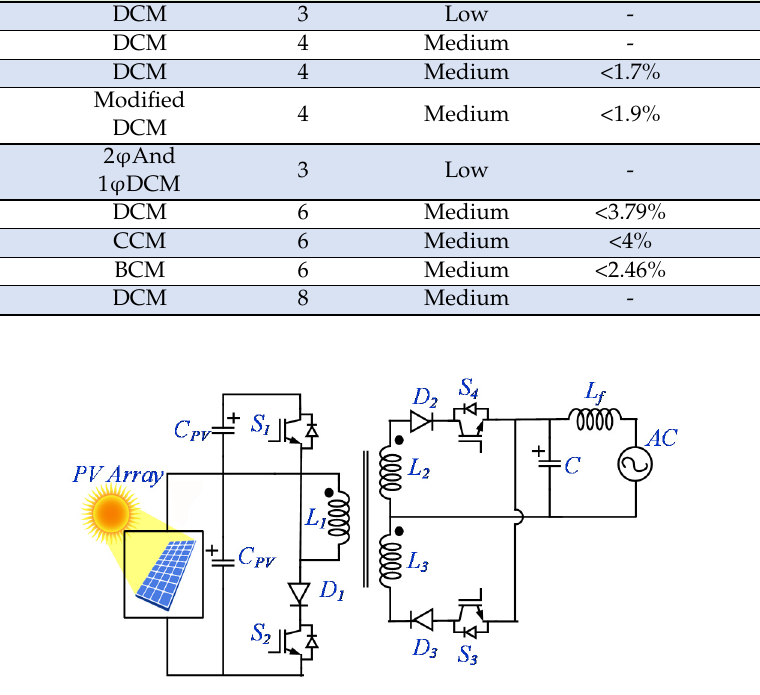
Figure 20. Single stage fly-back inverter .